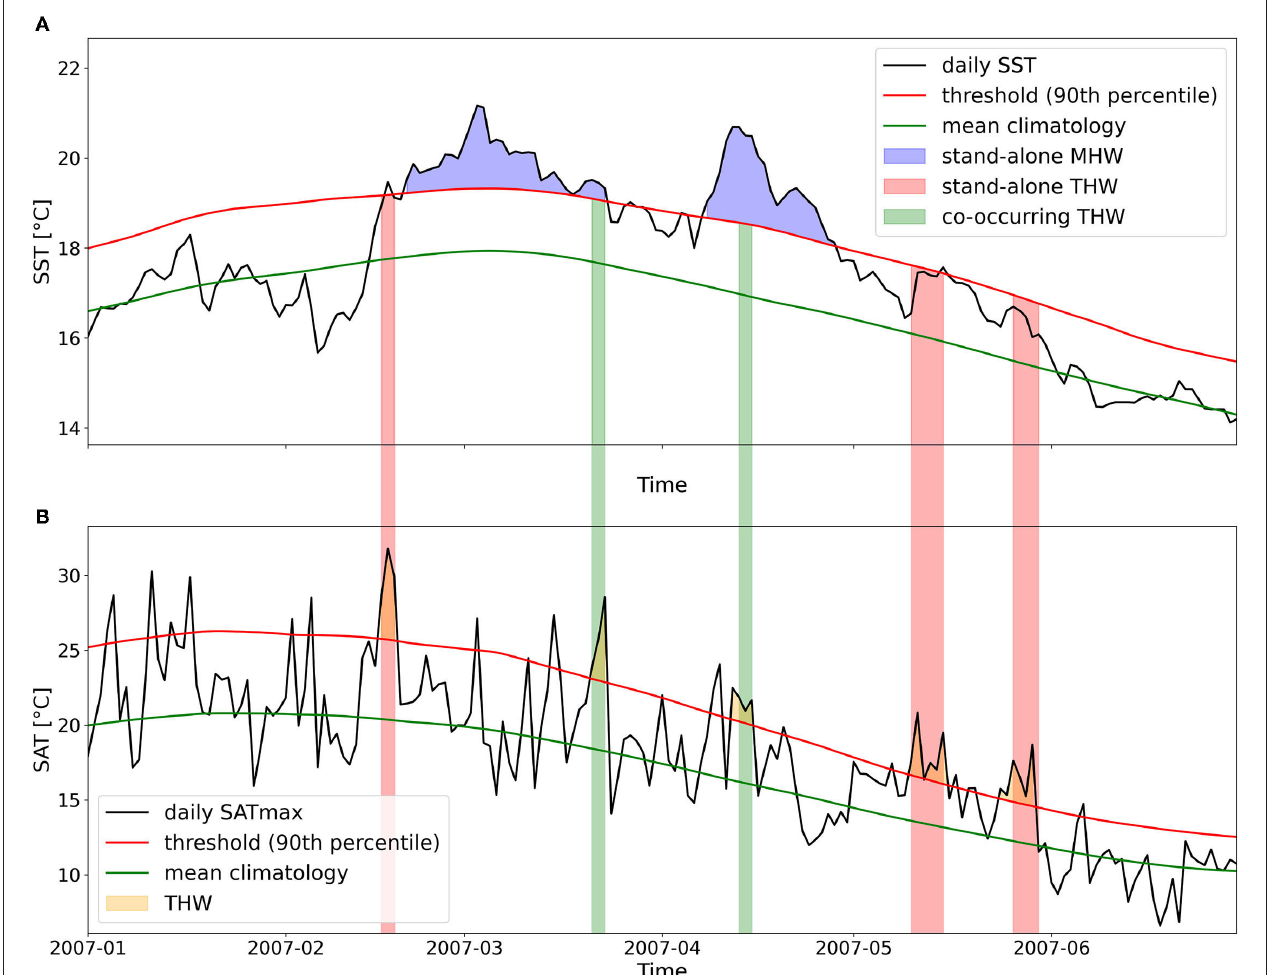
FIGURE 1 | Schematic illustrating stand-alone and co-occurring heatwaves. (A) SST and (B) SAT from (42.12S, 149.9E) and (42S, 148E) respectively. Each MHW is divided into its build-up and decay phases based on the maximum SST of the event. THW may co-occur with the build-up or decay phases of MHW (green bars) or independently of a MHW (red